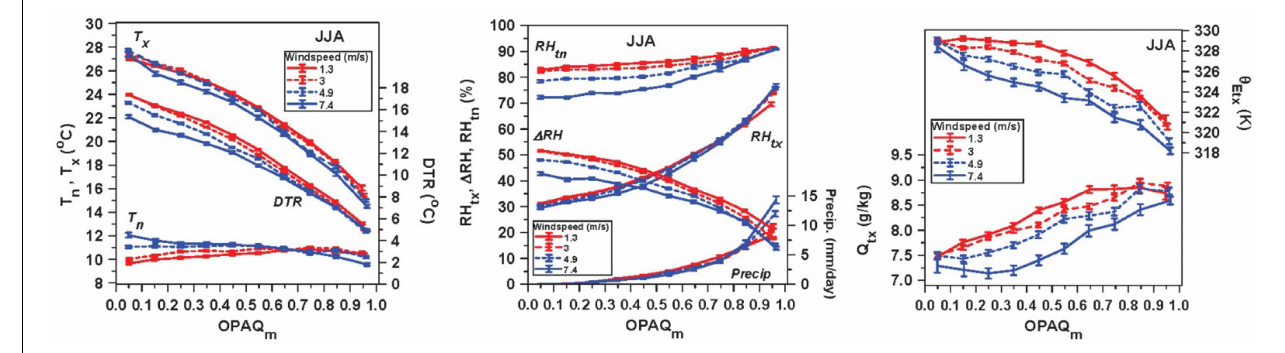
FIGURE 9 | Coupling of daily climate to opaque cloud and